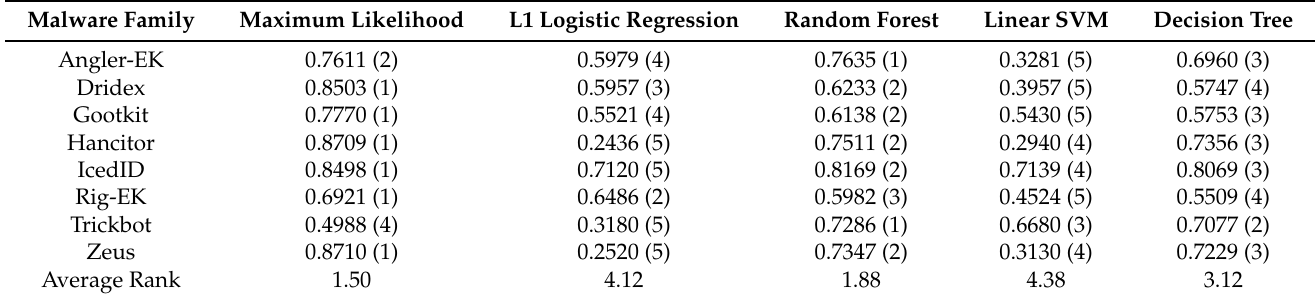
Table 3. AUC values for each classifiers using Markov chain fingerprinting with average rank.